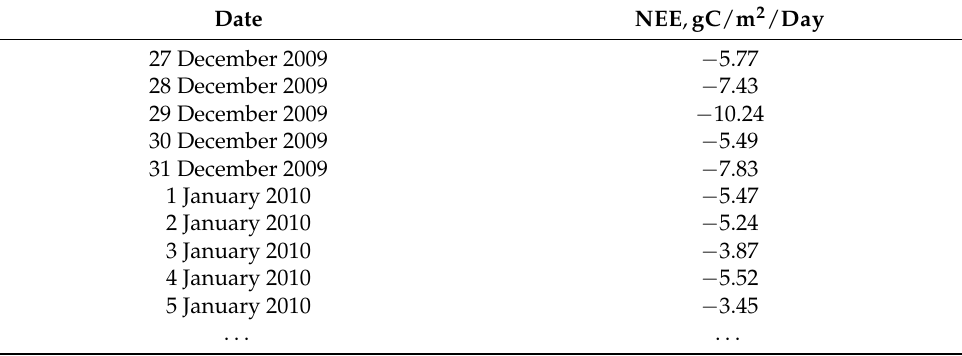
Table 2. Example of “target” NEE from eddy covariance stations for each